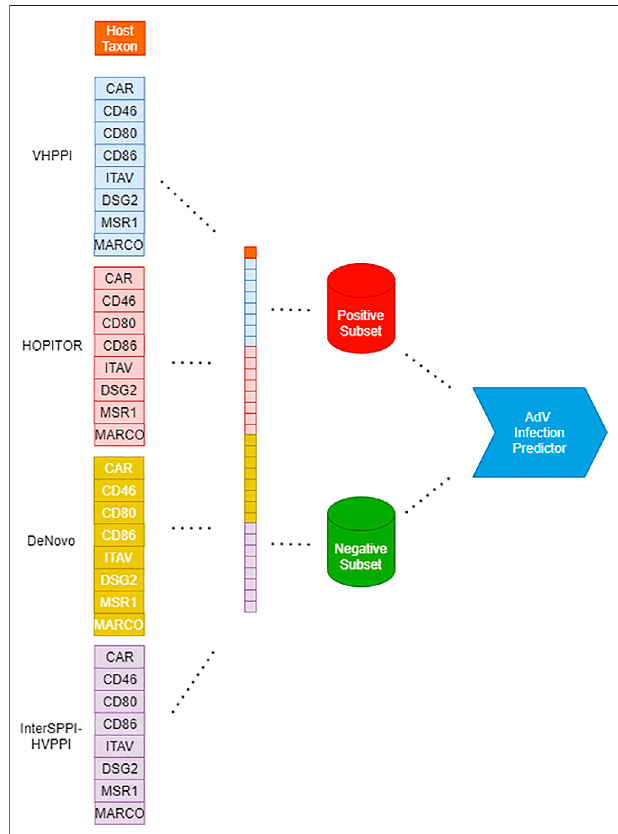
FIGURE 1 | Work fl ow for creation of adenoviral infection prediction models from left to right: Creation of feature vector based on virus-host PPI predictors,hosttaxa, andinfection class;partitioningofthedatasetaccording to the class. Finally, creation of an infection predictor through various machine-learning algorithms such as RF, SVM, and